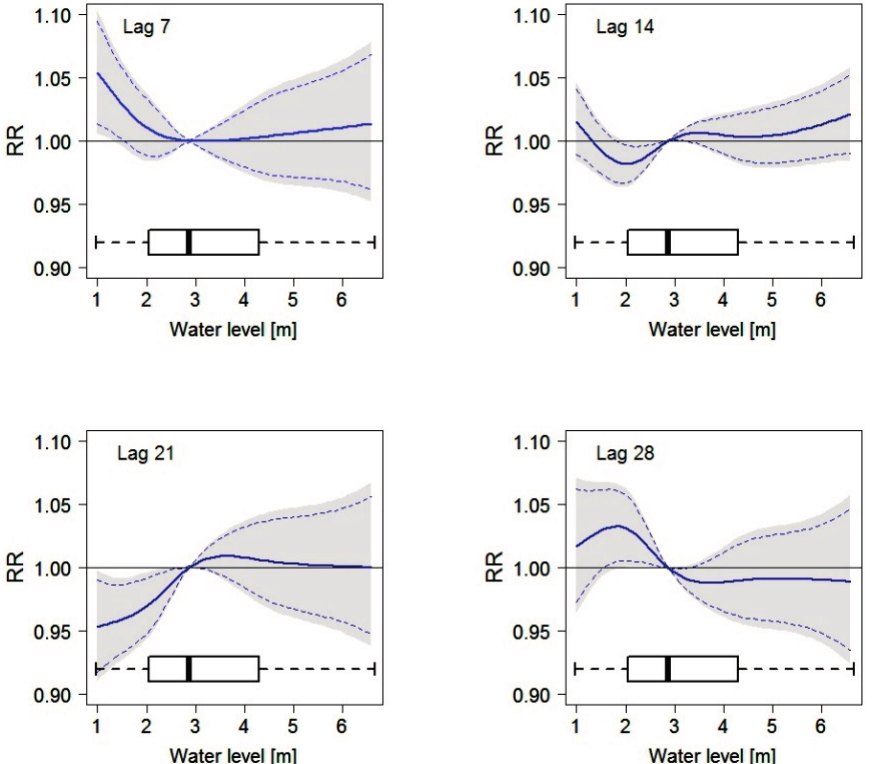
Figure 8. Relationship between the daily number of deaths and the water level in Dhaka for a lag period of 7, 14, 21 and 28 days using a distributed lag non-linear model. Curves are adjusted for trend, season, and day of the month. Grey areas display upper and lower 95% confidence intervals; dashed lines display upper and lower 90% confidence intervals. Boxplots for the water level distribution are included at the bottom of each